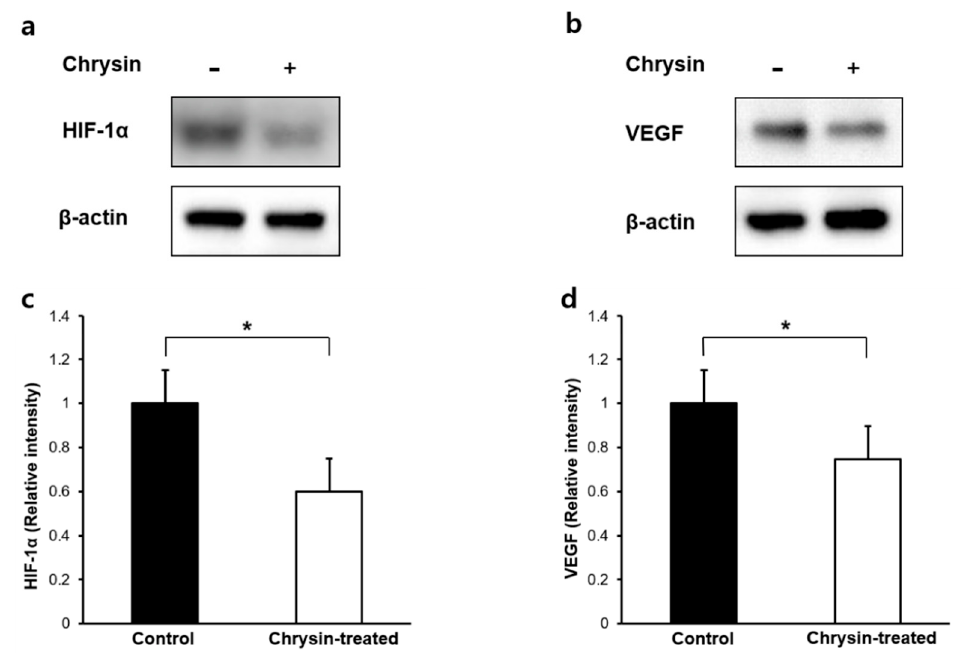
Figure 3. E ff ect of chrysin on hypoxia inducible factor (HIF)-1 α and vascular endothelial growth factor (VEGF) expression in the chrysin-treated and control groups. HIF-1 α ( a ) and VEGF ( b ) protein levels detected by immunoblotting showed that chrysin inhibited HIF-1 α and VEGF protein expression. Relative band intensity of HIF-1 α ( c ) and VEGF ( d ) protein normalized to β -actin revealed significantly decreased expression in the chrysin-treated group than in the control group ( n = 15 eyes / group; * p < 0.001, Mann-Whitney U tests). Error bars indicate the standard error. HIF-1 α , hypoxia inducible factor-1 alpha; VEGF, vascular endothelial growth